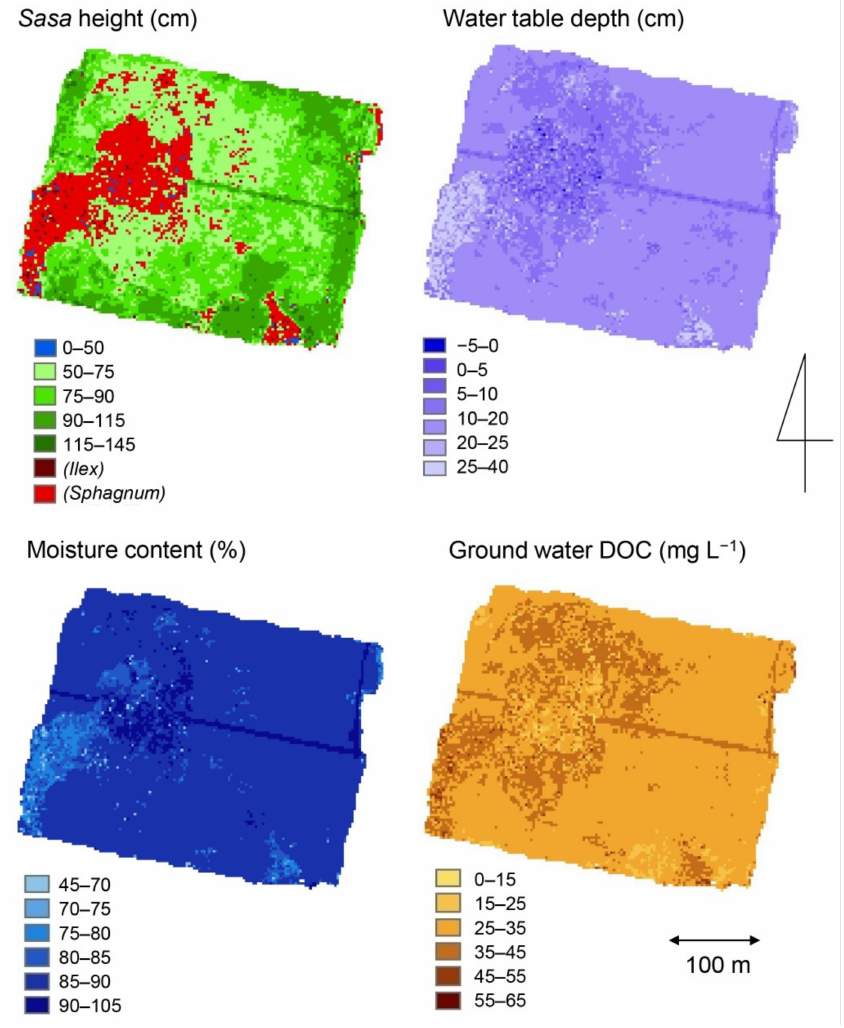
Figure 7. Spatial distributions of environmental factors in the Bibai Wetland estimated using a satellite